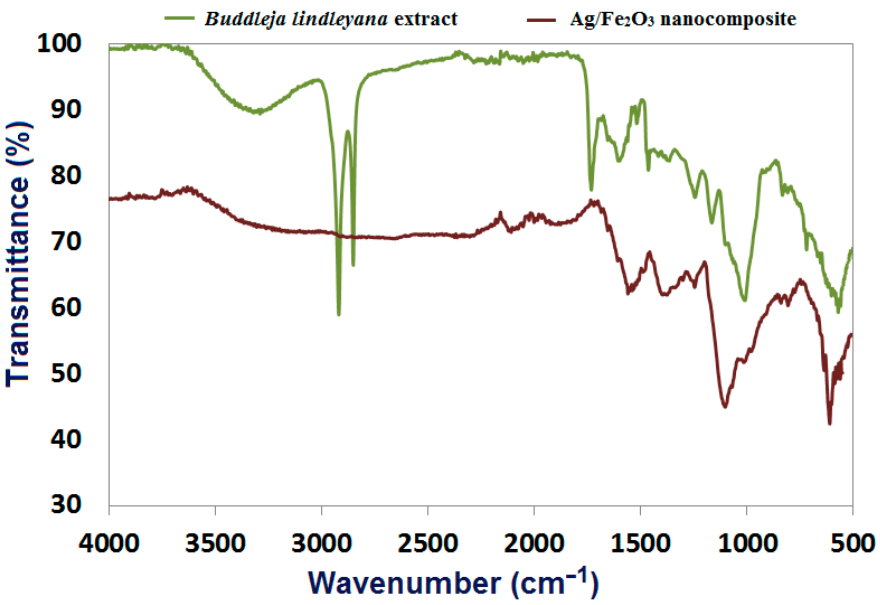
Figure 3. FTIR spectral analysis of Buddleja lindleyana extract and Ag/Fe 2 O 3 nanocomposite.